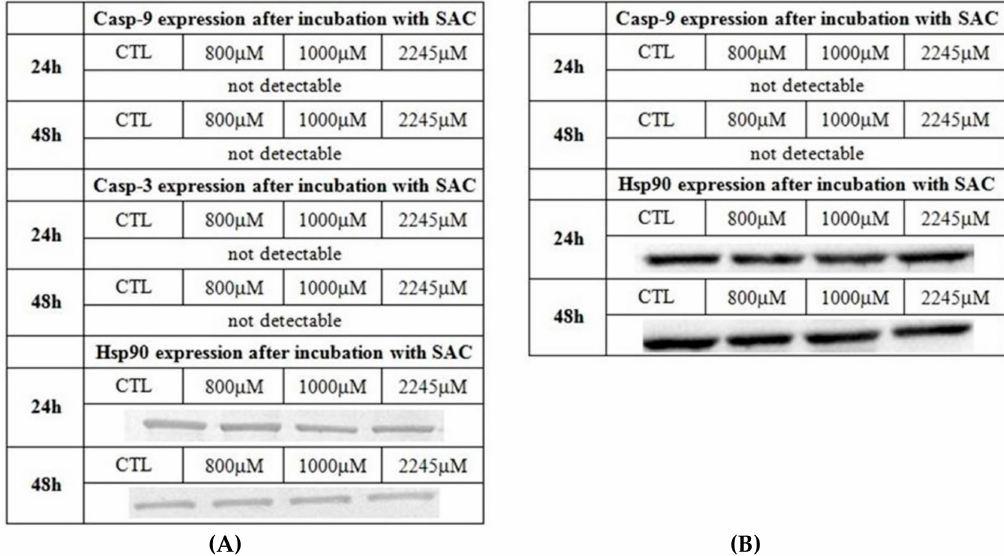
Figure 6. The expression of caspase-3 (casp-3) and caspase-9 (casp-9), in the breast cancer cell line (MCF-7) after the 24 h and 48 h incubations with SAC. The tested concentrations of SAC in culture medium as listed: 800 µ M, 1000 µ M and 2245 µ M, and the control refers to non-treated cells ( A ) Western blot with immunodetection. Each experiment was done tree times in triplets, and a representative experiment is shown. Hsp90 is used as a control of equal loading. ( B ) Western blot with chemiluminescence